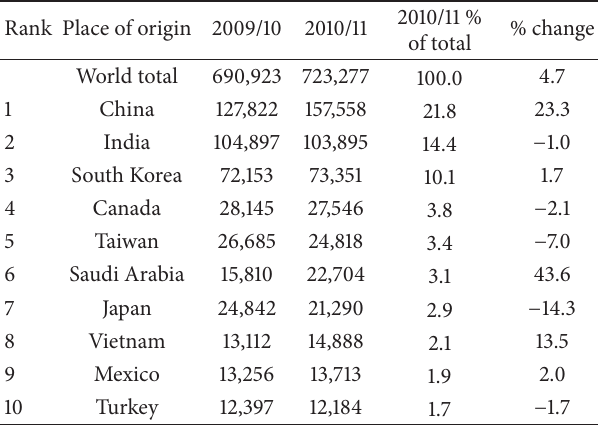
Table 1: Top 10 places of origin of international students, 2009/10-